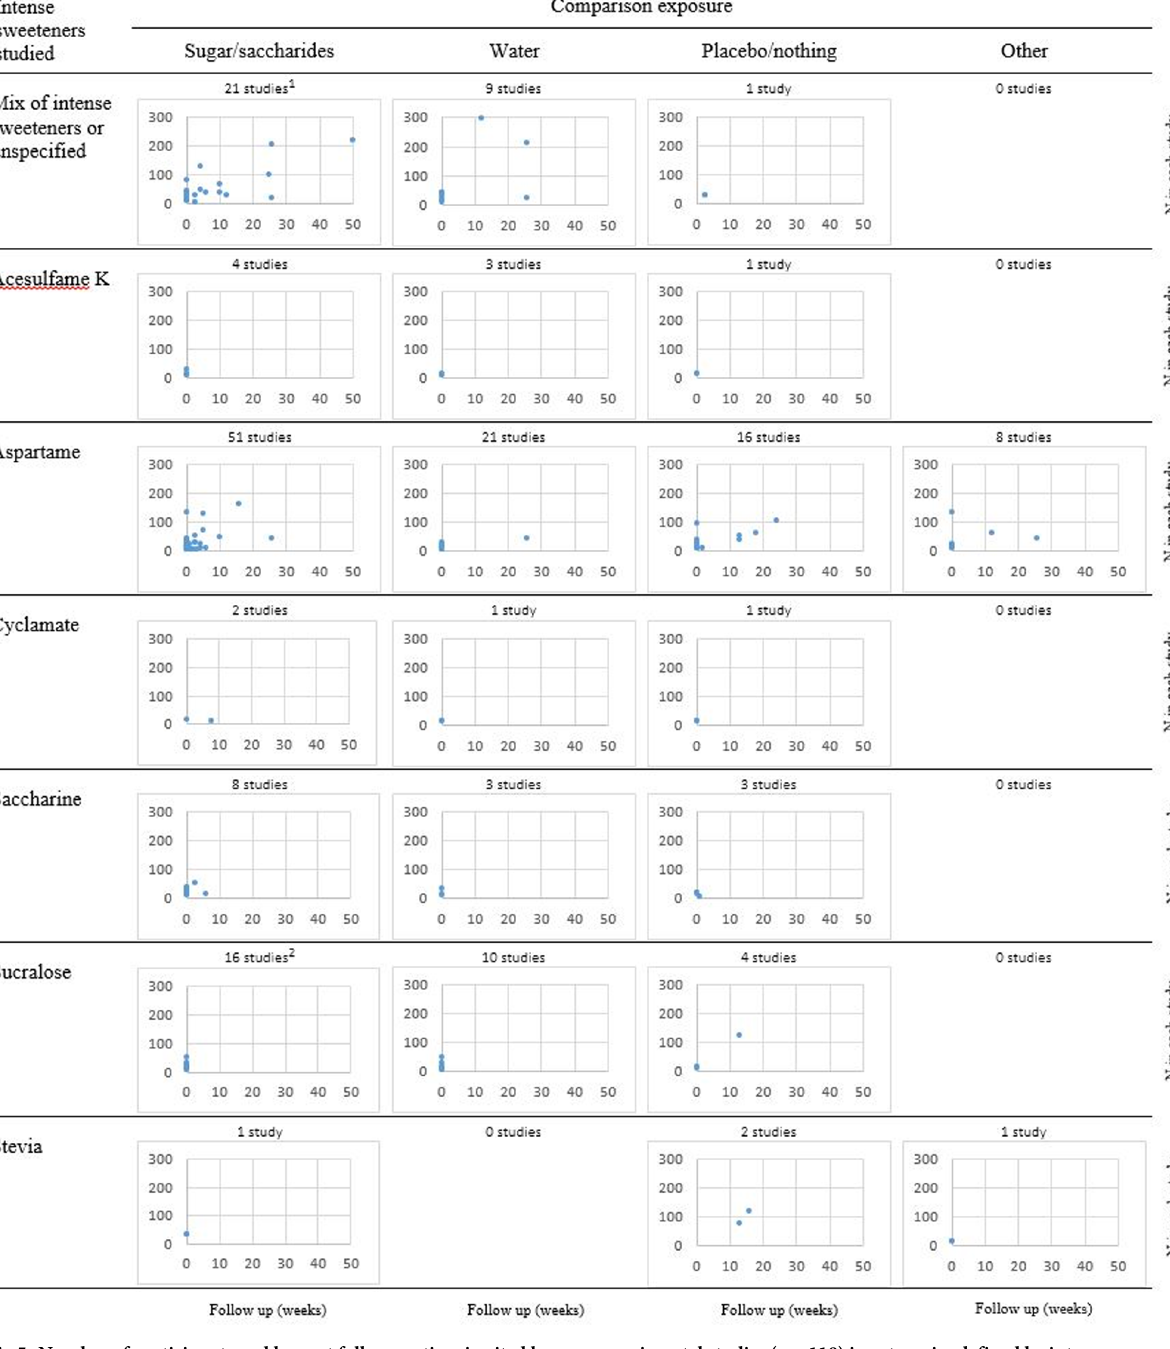
Fig 5. Number of participants and longest follow-up time in cited human experimental studies (n = 118) in categories defined by intense sweeteners versus comparator studied. Data from the reviews in Table 1 that presented characteristics on all included primary studies. a One study with 641 participants and 78 weeks follow-up outside chart area. b One study with 414 participants and 43 weeks follow-up outside chart